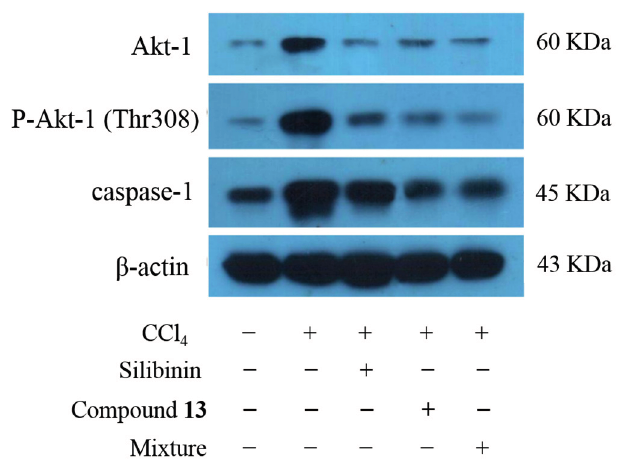
Figure 4. Expression level of caspase-1 and Akt-1 in